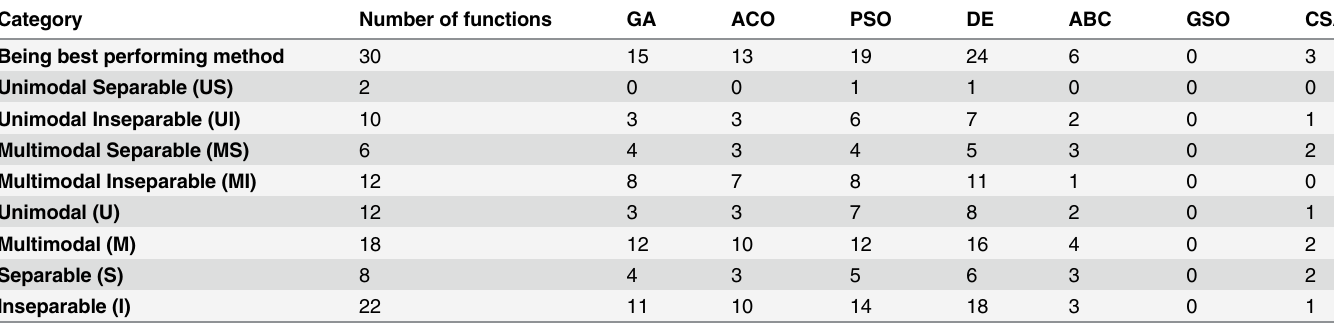
Table 9. Performance breakdown based on the benchmark functions ’